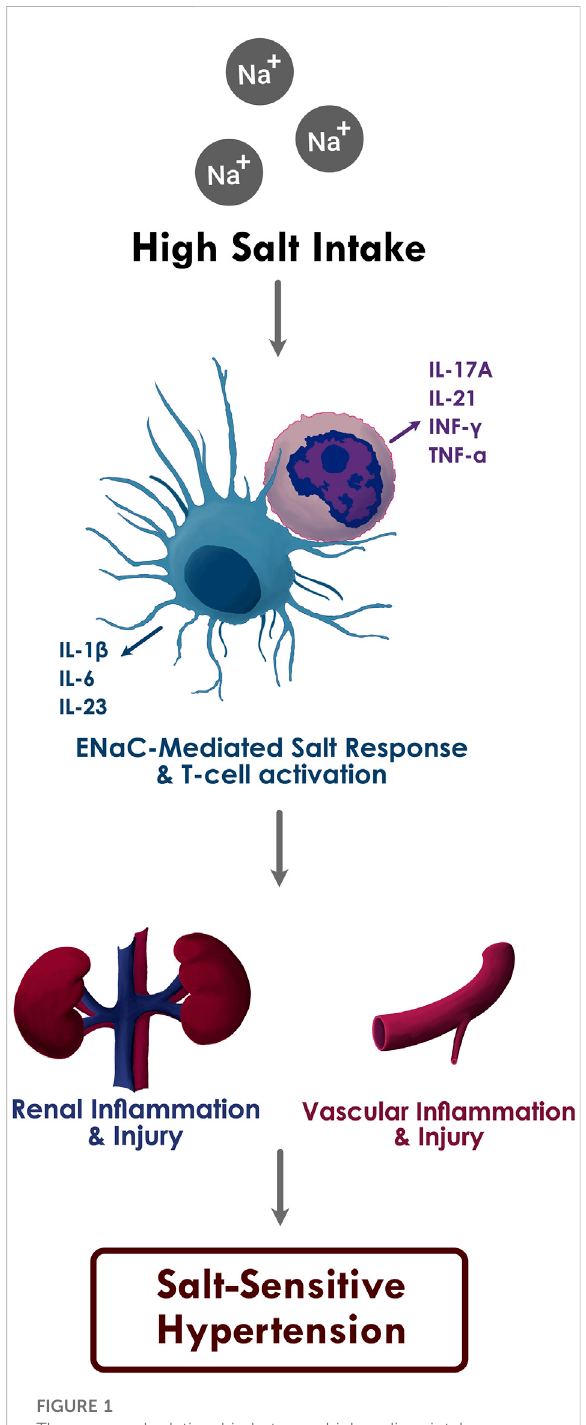
The proposed relationship between high sodium intake, in fl ammation, and salt sensitive